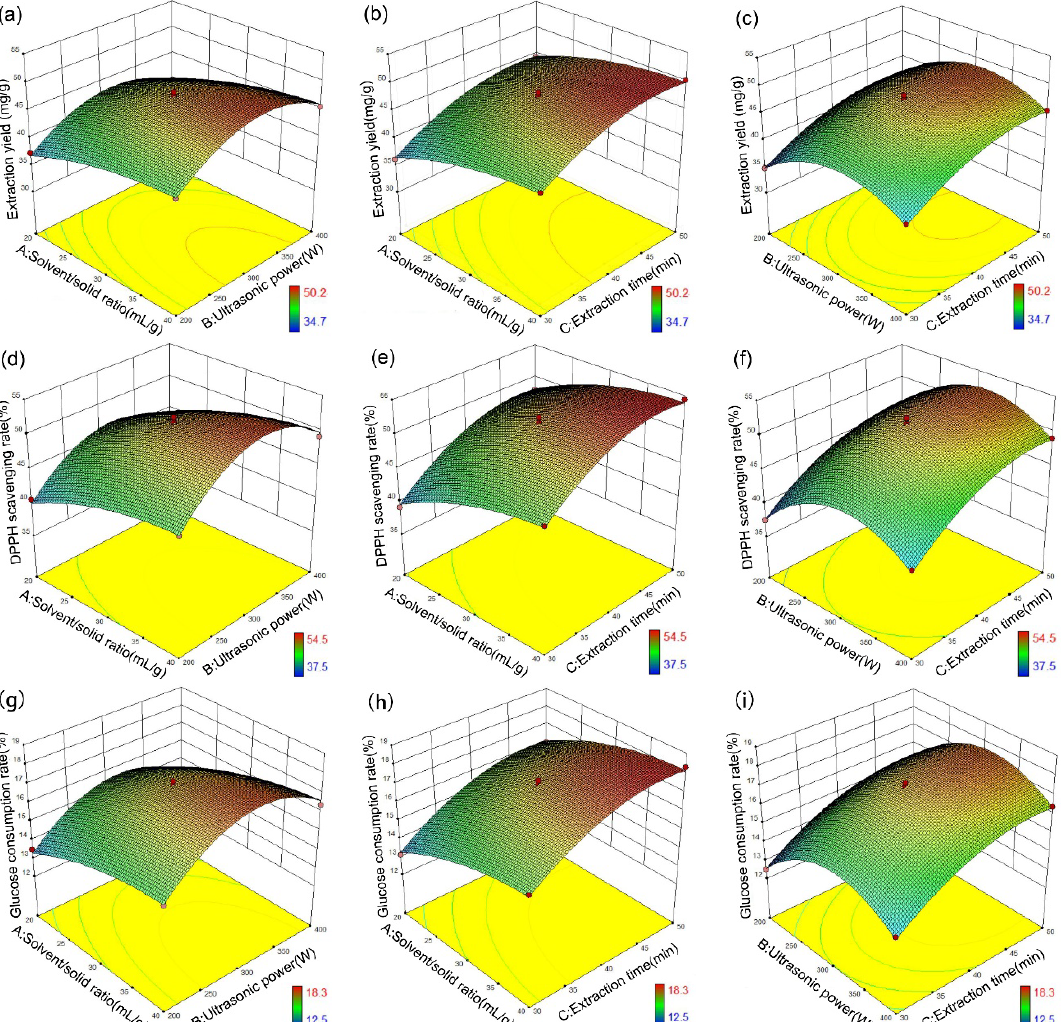
Figure 5. Response surfaces for the interactions of independent variables (A: solvent/solid ratio, B: ultrasonic power, and C: extraction time) on ( a – c ) extraction yield, ( d – f ) DPPH scavenging rate and ( g – i ) glucose consumption rate.